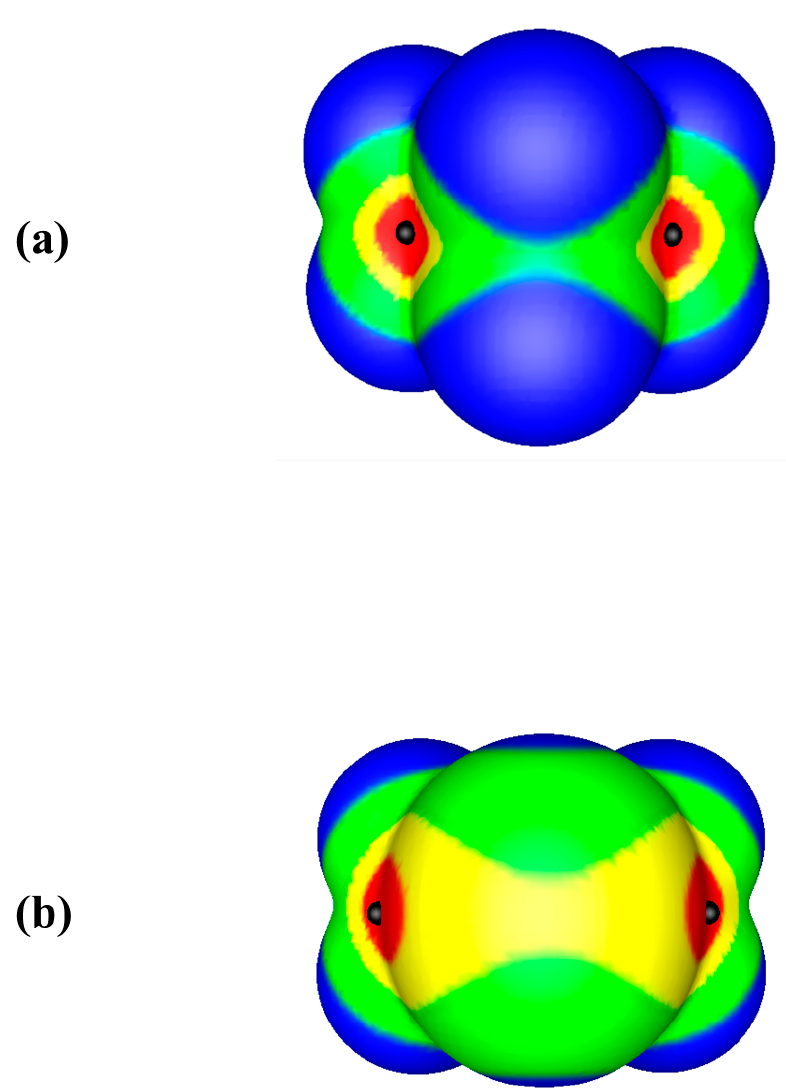
Figure 4. Computed electrostatic potential on 0.001 au molecular surface of the heterocycle 1 . ( a ) One CF 2 group is in the center foreground, the other two are in the left rear and right rear. Black hemispheres indicate V S,max near centers of C–C bonds. ( b ) The selenium is in the foreground, two CF 2 groups are visible at left rear and right rear. Black hemispheres correspond to V S,max near centers of Se-C bonds. Color ranges, in kcal/mol: red, more positive than 20; yellow, between 20 and 10, green, between 10 and 0; blue, negative.